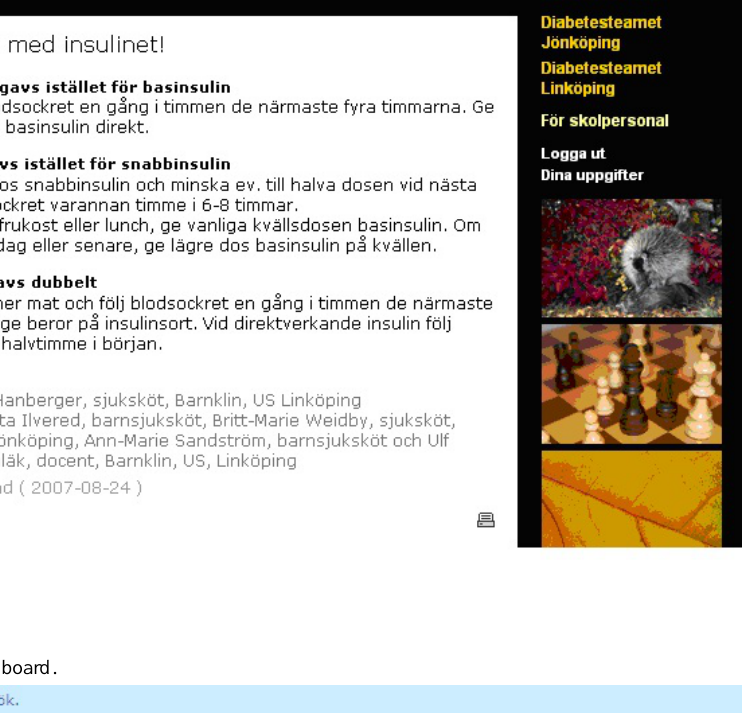
Figure 2. Screenshot from the Diabit portal. “I made a mistake with the insulin”, and how to manage.